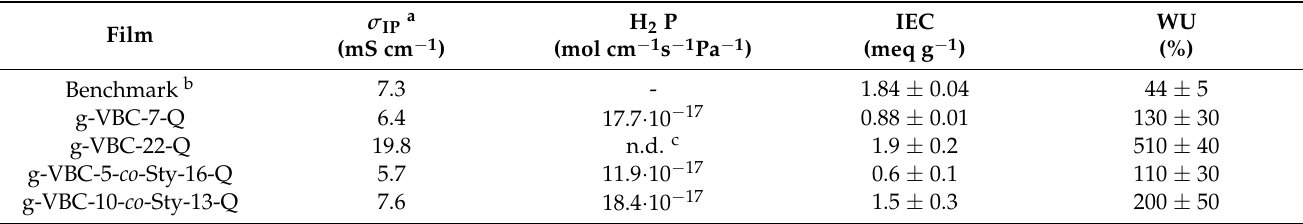
Table 5. Electrochemical properties of the aminated